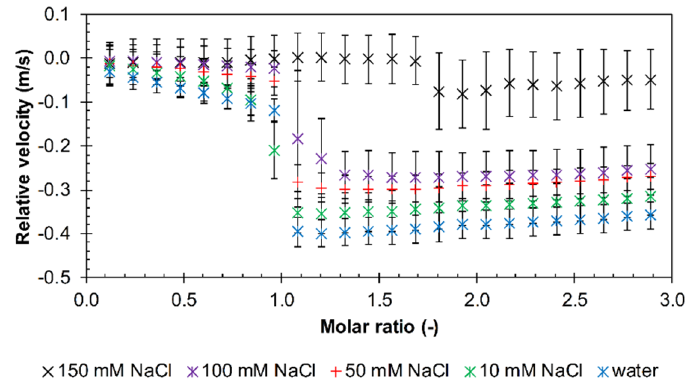
Figure 4. The relative ultrasonic velocity in dependence on the molar ratio for titrations of arginine dodecamer in hydrochloride form into 680 kDa hyaluronan solutions in different ionic strength environments (11.6 MHz, 25 °C).